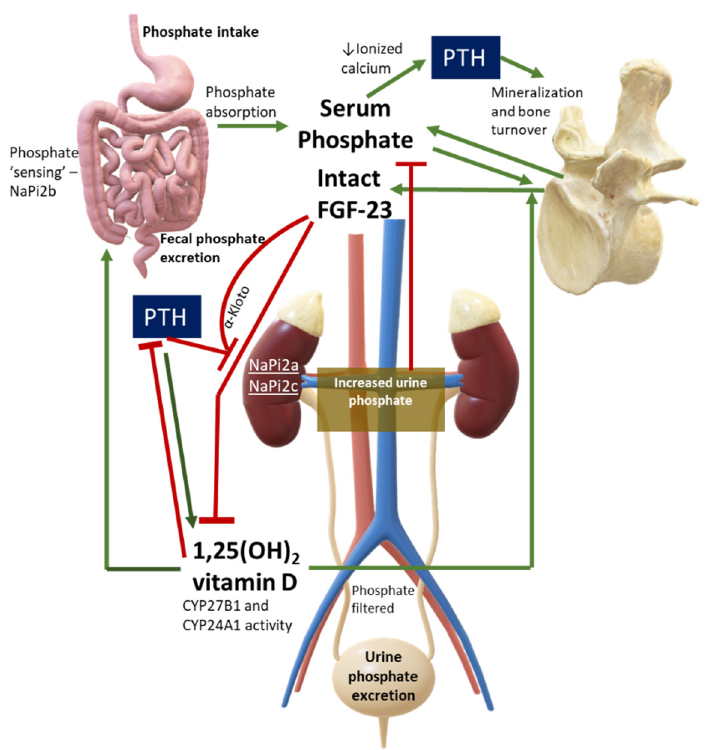
Figure 1. Phosphate Physiology. Green lines are stimulatory pathways, while red lines stand for inhibitory pathways. This figure can also be used to interpret diseases with PTH or FGF-23 excess or deficiency, or in case of abnormalities in phosphate cotransporters. Legend: CYP27B1, 1-alpha hydroxylase; CYP24A1, vitamin D 24-hydroxylase; NaPi, sodium-phosphate cotransporter.